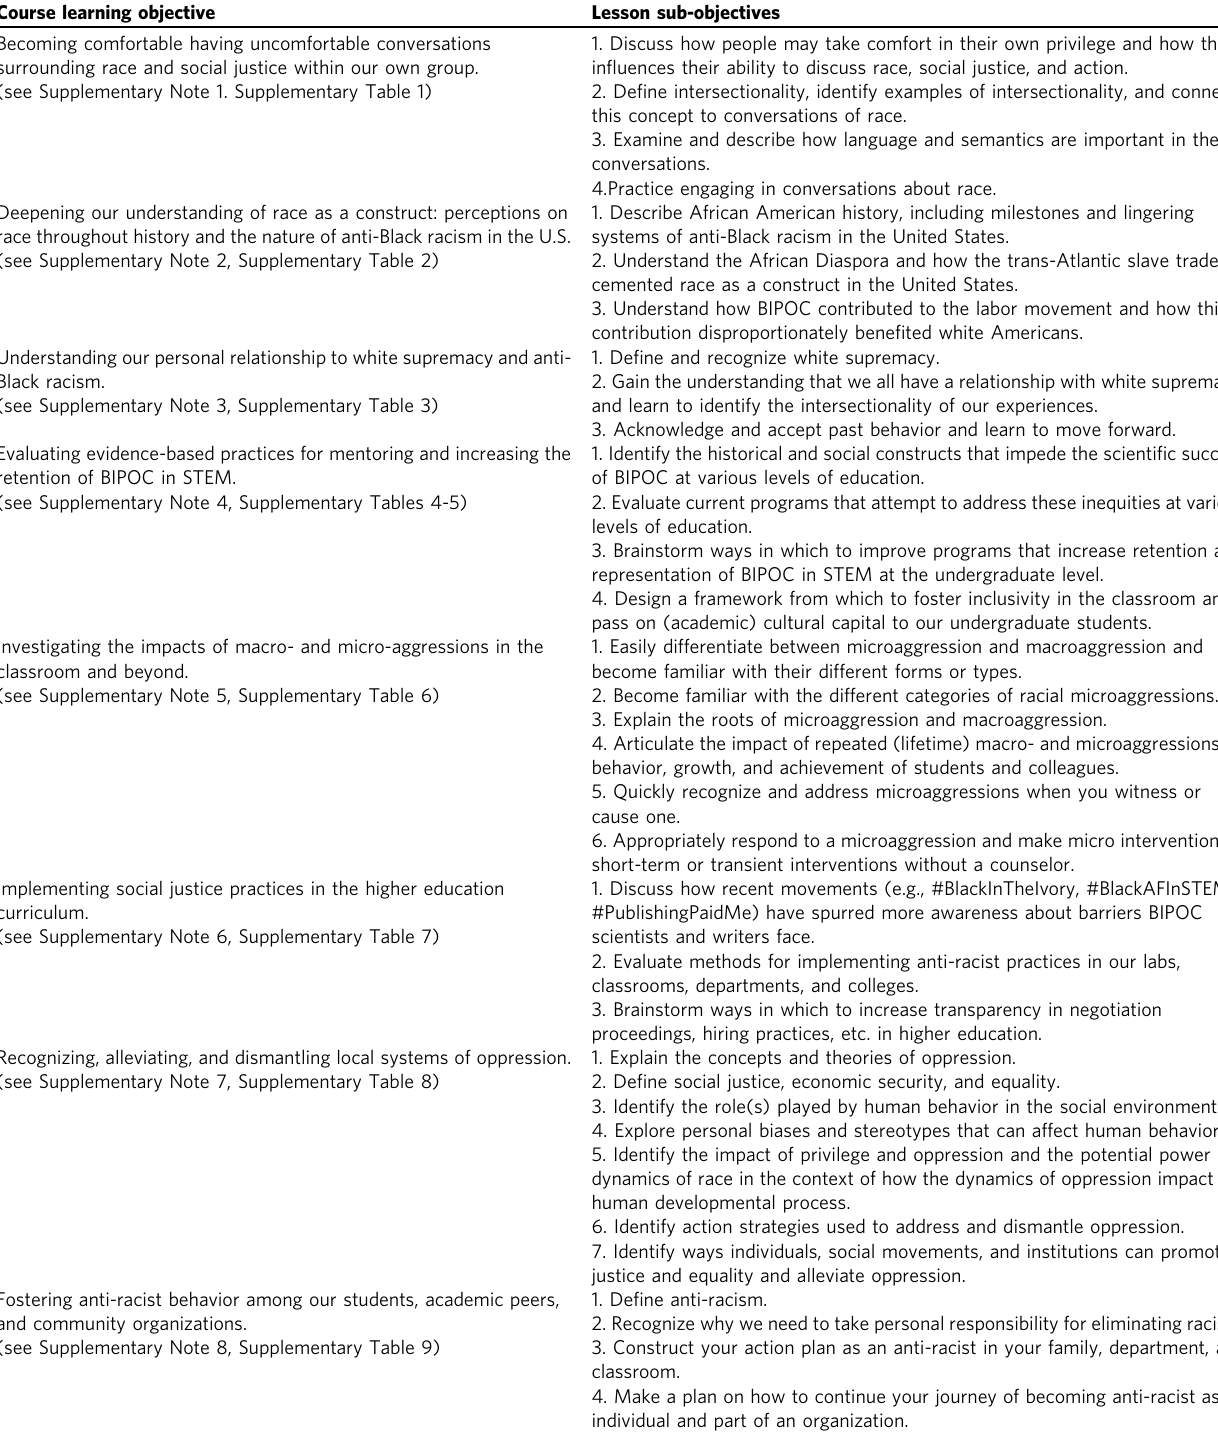
Table 1 Course learning objectives were agreed upon by the